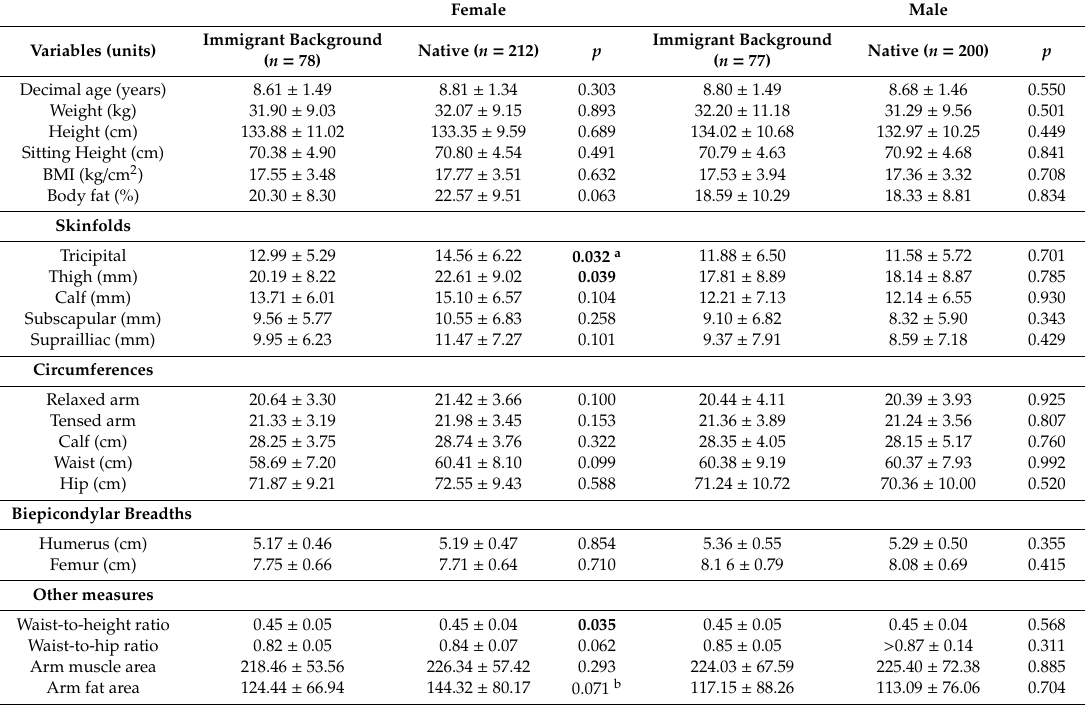
Table 4. Comparisons of variables (mean ± SD) between children with immigration background versus native parents, stratified by